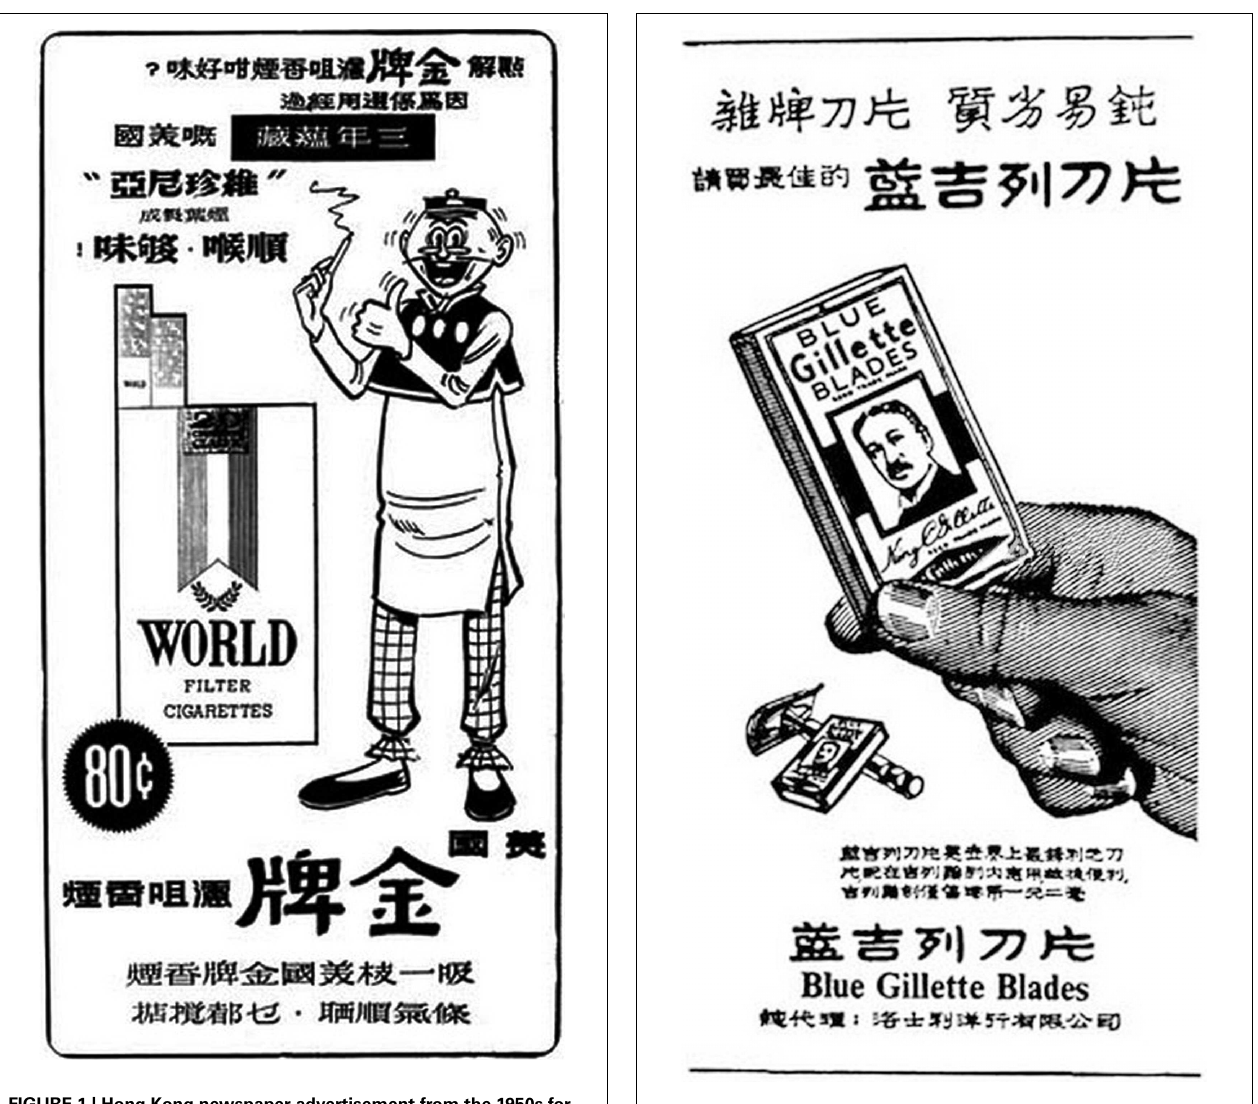
FIGURE 2 | Hong Kong newspaper advertisement from the 1950s for Blue Gillette Blades. The Chinese script (Written Chinese) in this advertisement for “Blue Gillette Blades” is in the newer LR direction. (Source: